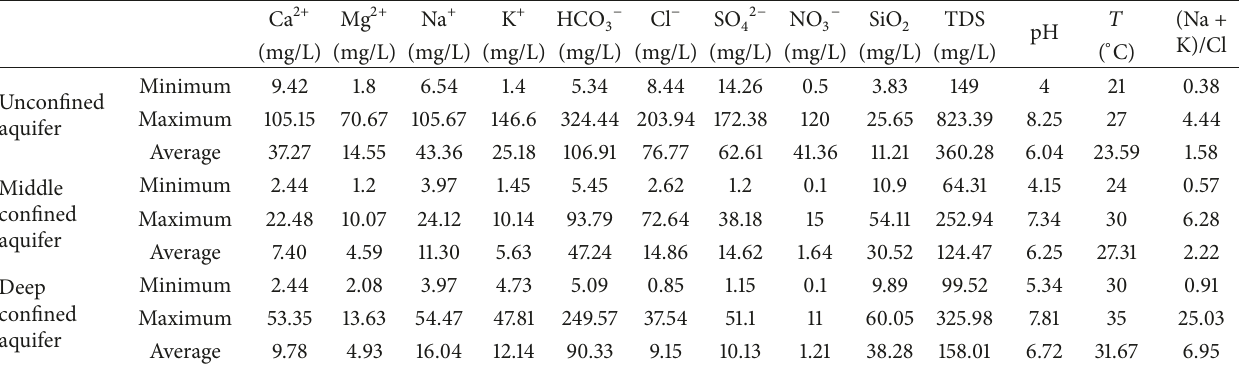
Table 3: Statistical results of groundwater chemistry data of the multilayered aquifer system of Zhanjiang.